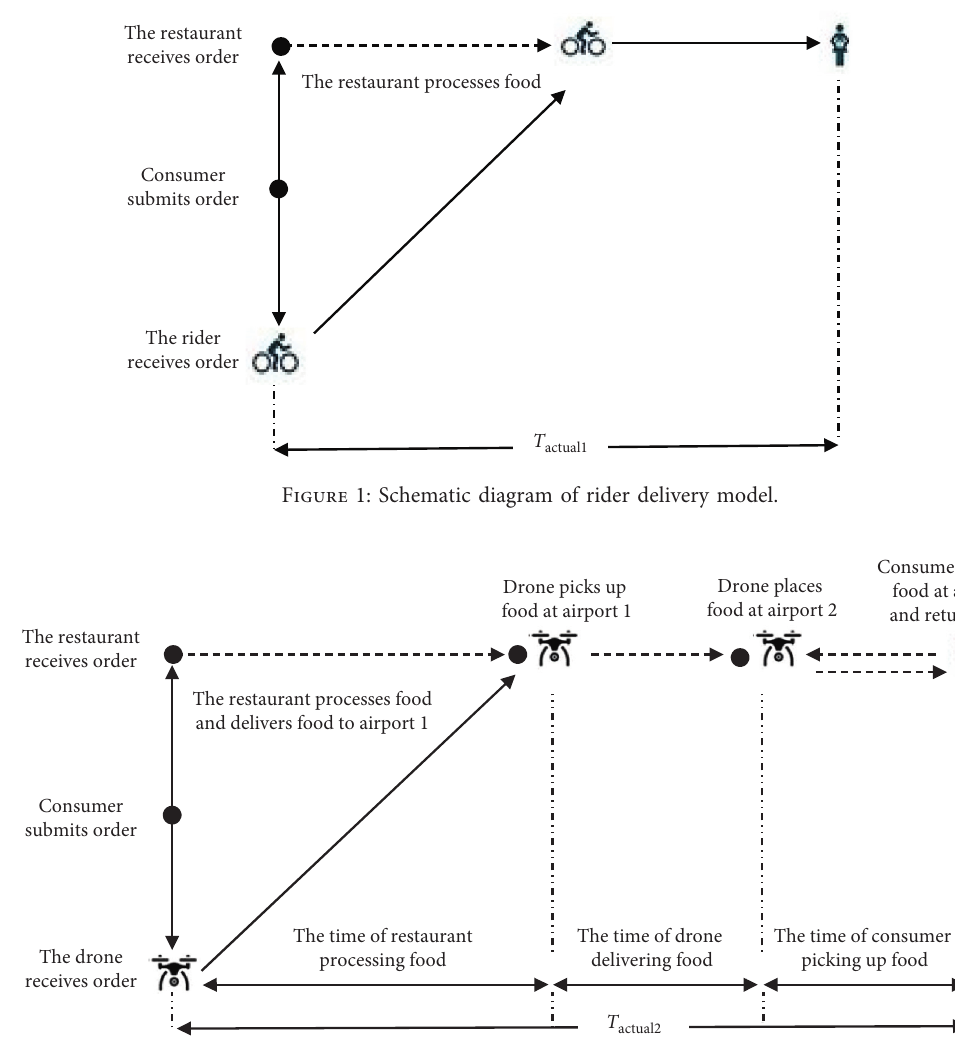
Figure 2: Schematic diagram of drone delivery model.